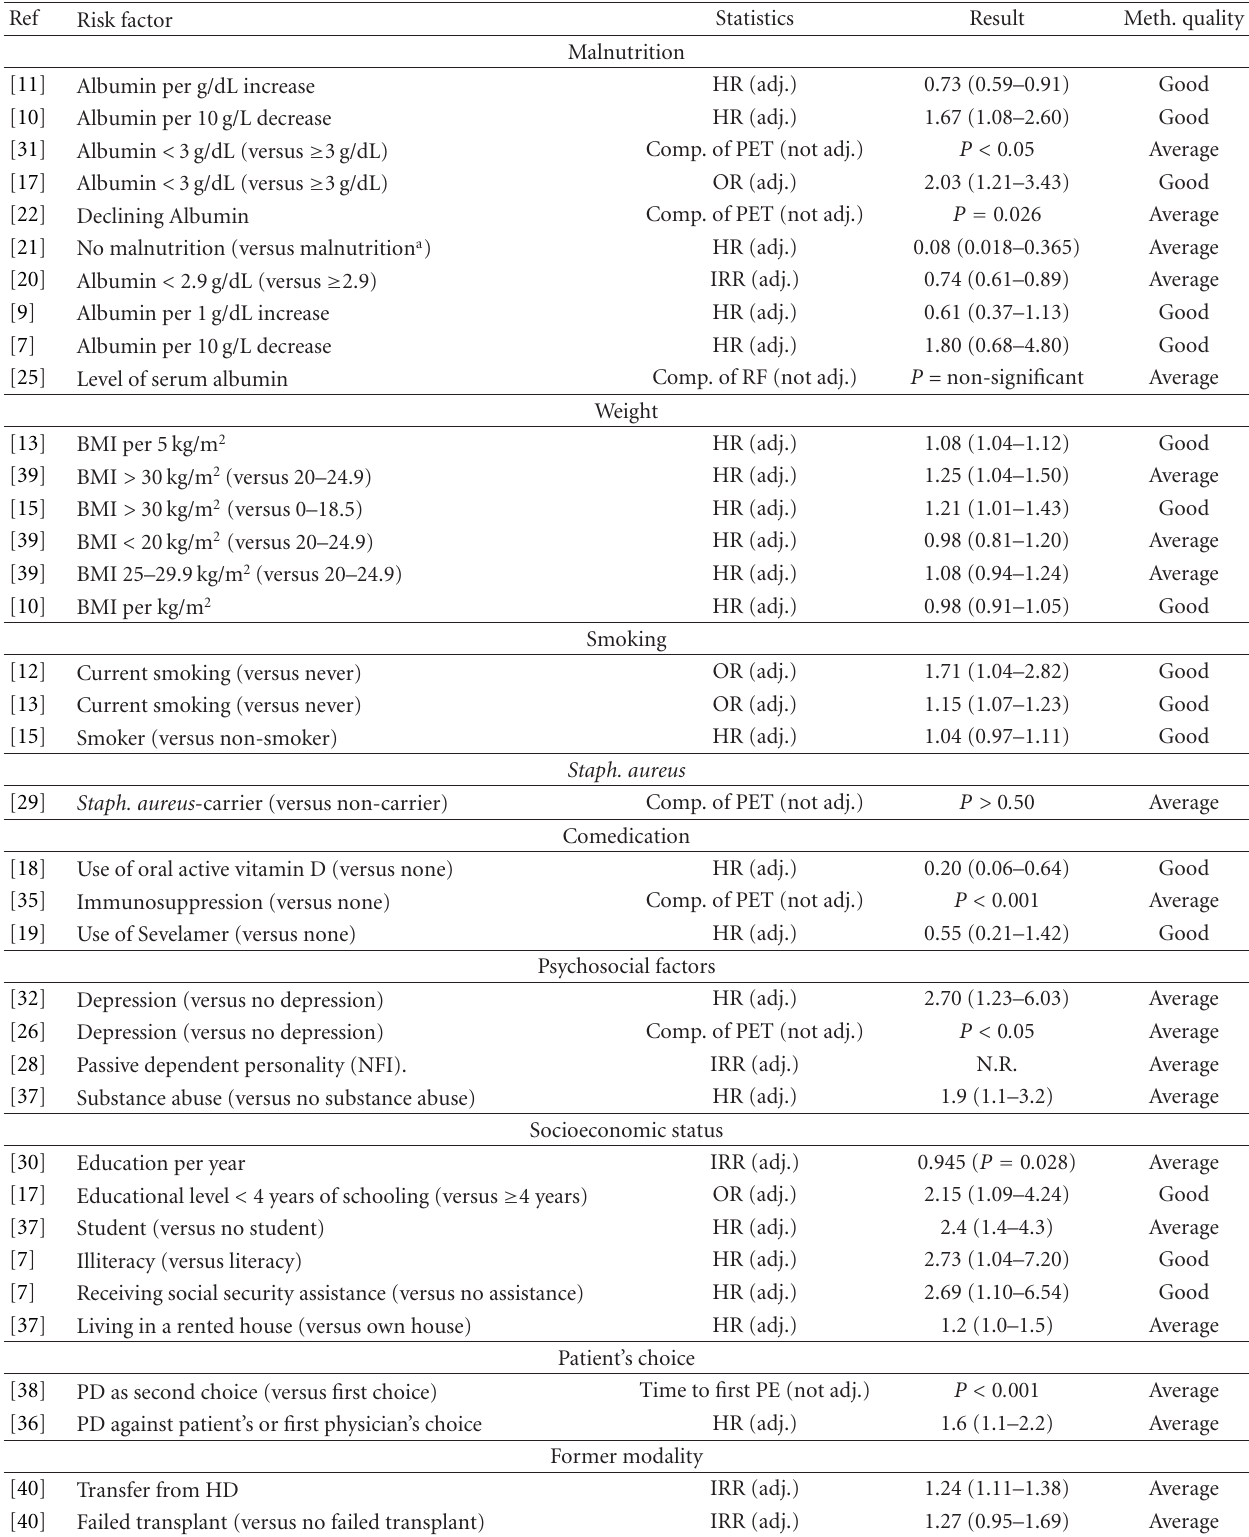
a Assessed by Subjective Global Assessment; BMI: body mass index. Comp. of PET: comparison of peritonitis episodes per time period. Comp. of RF: Comparison of levels of studied risk factor (peritonitis versus no peritonitis). HR: hazard ratio. OR: odds ratio. PE: peritonitis episode. Staph. aureus : Staphylococcus aureus . NFI: no further